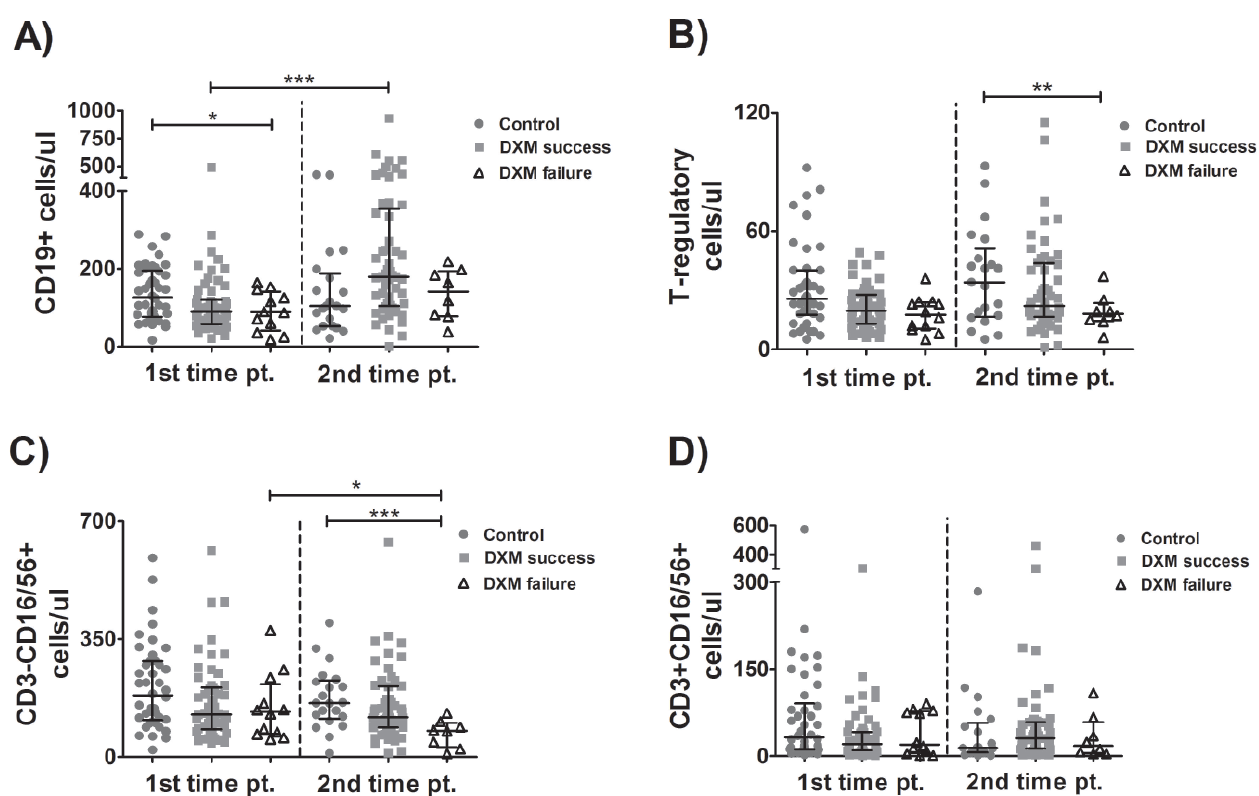
Figure 4. Kinetics of B-cells, Tregs, NK and NKT cells.Lymphocyte subpopulations were evaluated over time in blood samples from patients with COVID-19 who received (or not) treatment with dexamethasone. B-lymphocytes ( A ), T-regulatory cells-Tregs ( B ), Natural-killer cells ( C ) and Natural- killer T-cells ( D ) were determined with flow cytometry. Multiple comparisons were made using Kruskal–Wallis with Dunn’s post-hoc tests. Comparisons between the two groups were made with Student’s T -test or the Mann–Whitney U-test as indicated. DXM: Dexamethasone. p -values < 0.05 were considered significant. * p < 0.05, ** p < 0.01, *** p < 0.001.